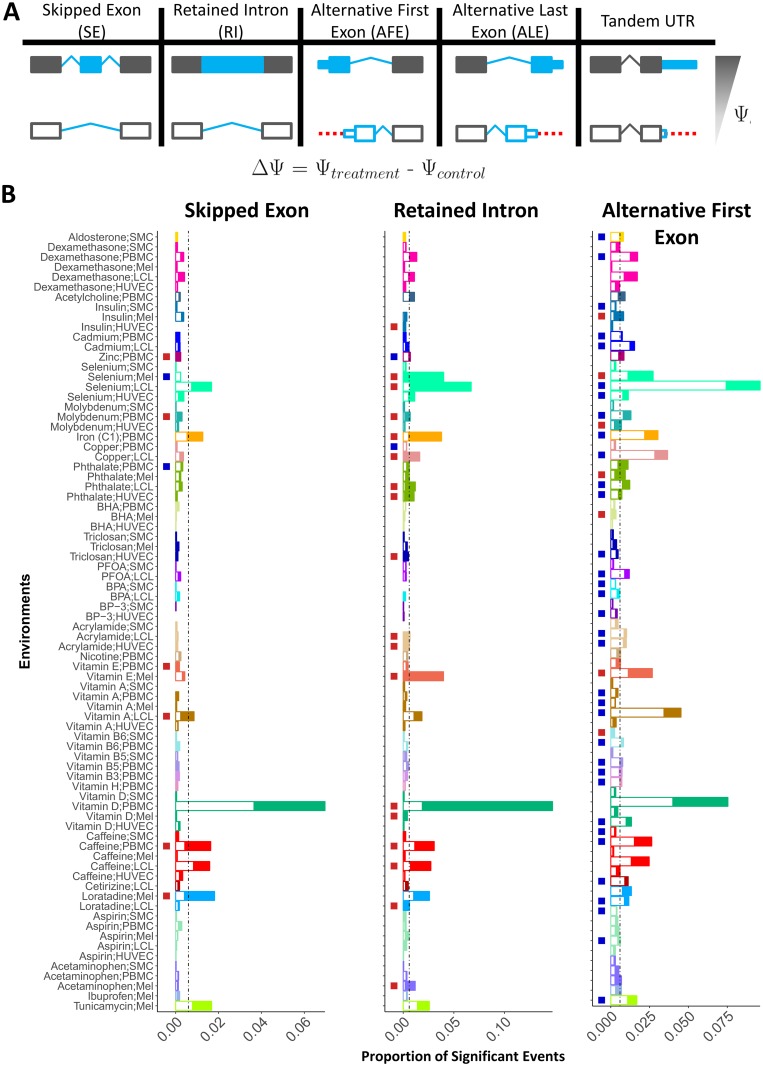
Direction of shift in events following treatment.A) Schematic of direction of event shifts for a given Ψ and ΔΨ. Shown for 5 event types.B) These plots indicate the direction of shift for 3 event types: SE (left), RI (middle) and AFE (right). Each plot shows 78 environments for whichthese events were tested. The height of each bar shows the proportion of significant event shifts for each environment and the dotted line indicatesthe average proportion of significant events across environments. Each bar is then broken in two with the shaded region showing the proportion ofthe significant changes that shifted towards a positive ΔΨ (inclusion of exon, intron or upstream AFE) while the white region of each bar is theproportion of sites with a negative ΔΨ. The column of boxes shows if there is a departure from the expected 50:50 for positive to negative ΔΨ(tested using a binomial test). Red denotes enrichment for ΔΨ > 0 and blue for ΔΨ < 0).